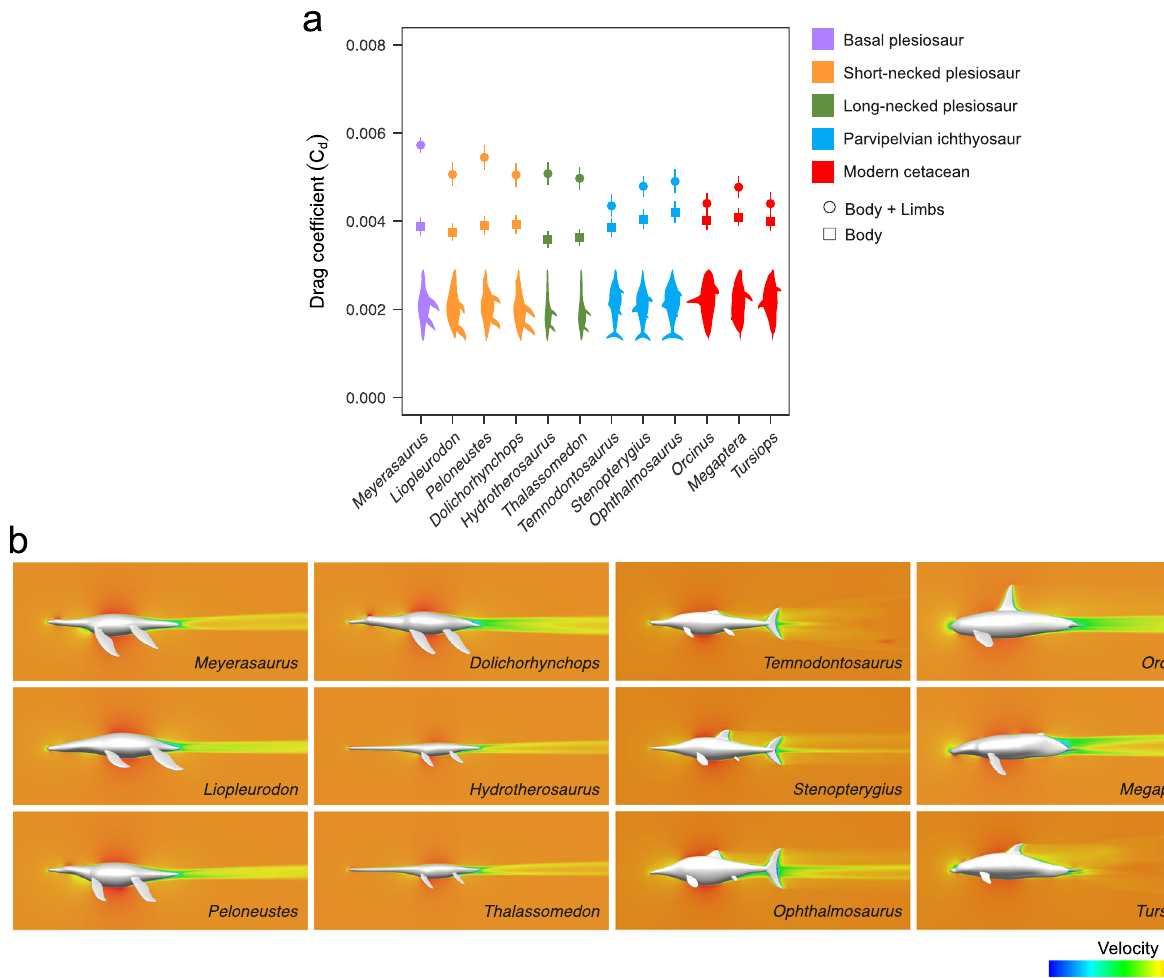
Fig. 1 Comparison of the drag coef fi cient of derived plesiosaurs, ichthyosaurs and cetaceans. a Total drag coef fi cient computed for the full models including the limbs ( ‘ body + limbs ’ , circles) and the limbless models ( ‘ body ’ , squares). Average (point) and range (bar) shown for calculations at Re = 5 × 10 6 – 10 7 . The derived short-necked plesiosaurs are highlighted in orange; the parvipelvian ichthyosaurs in blue and the extant cetaceans in red. A basal plesiosaur included as a reference is highlighted in purple. b Representative two-dimensional plots of the fl ow velocity magnitude at Re = 5 × 10 6 (inlet velocity of 5 ms − 1 ) in lateral view. For dorsal view see Supplementary Fig. 1. Images of Tursiops and the three ichthyosaurs modi fi ed from Gutarra et al. 29